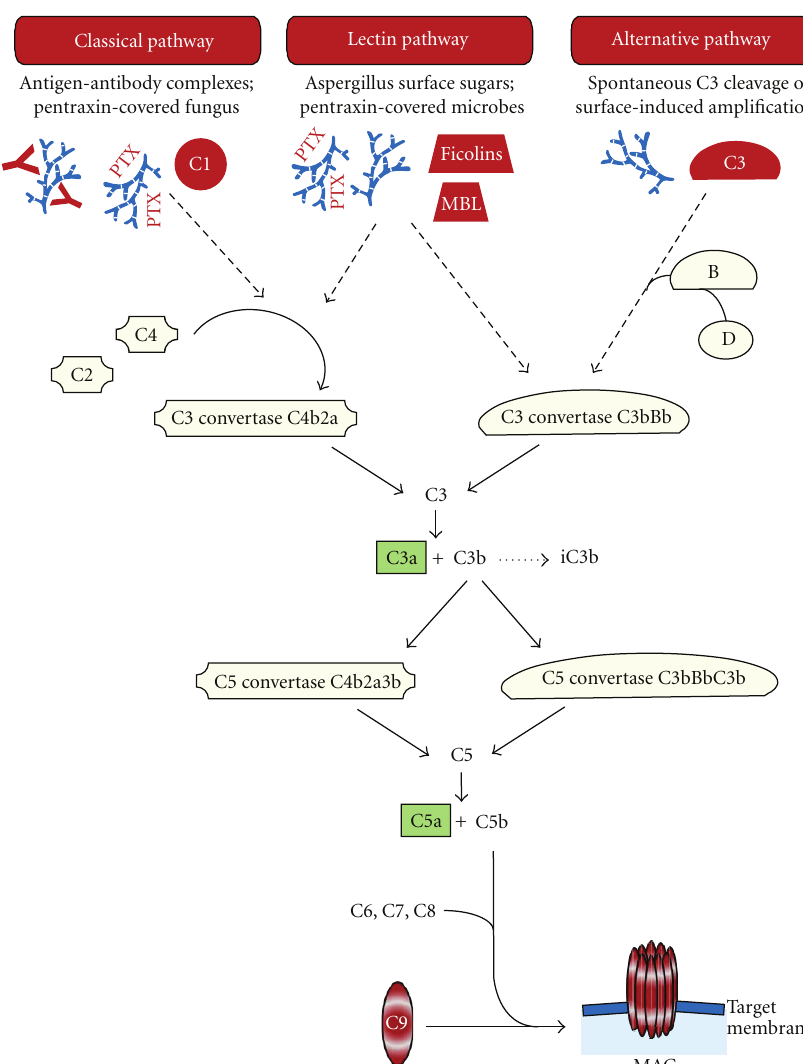
Figure 1: Scheme of complement activation pathways induced by Aspergillus and the subsequent course of the complement cascade. For details, see text. PTX: pentraxin; MAC: membrane attack